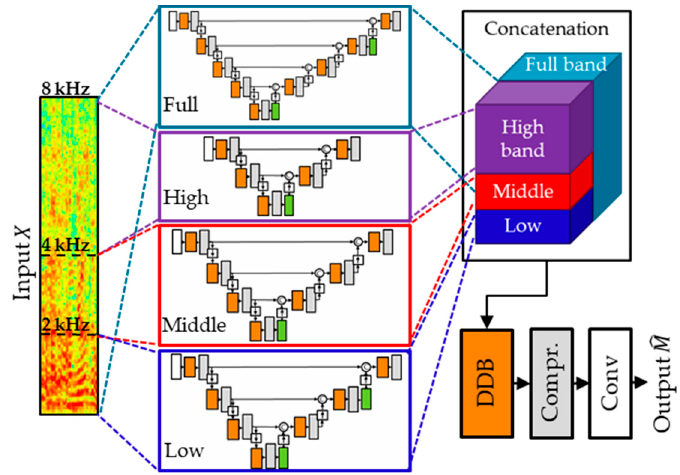
Figure 4. Proposed architecture for speech enhancement.